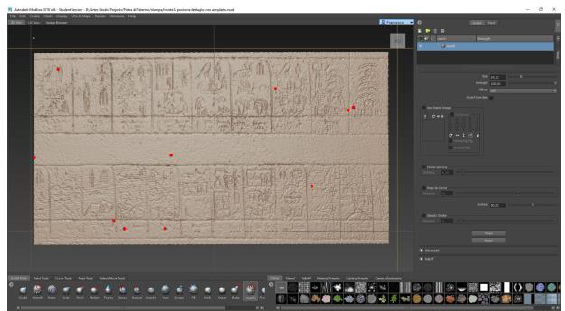
Figure 6: The digital sculpture tool Amplify to enhance the reading of the hieroglyphic writing.